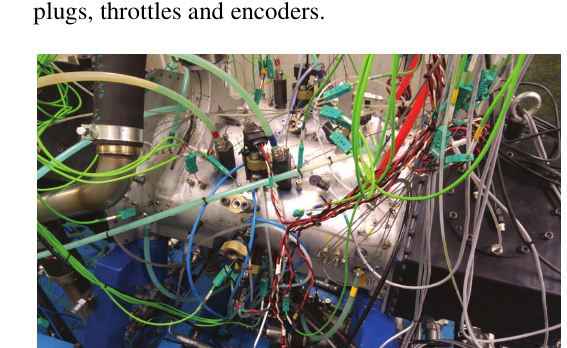
Fig. 9. 64 thermocouples embedded in PAMAR-4